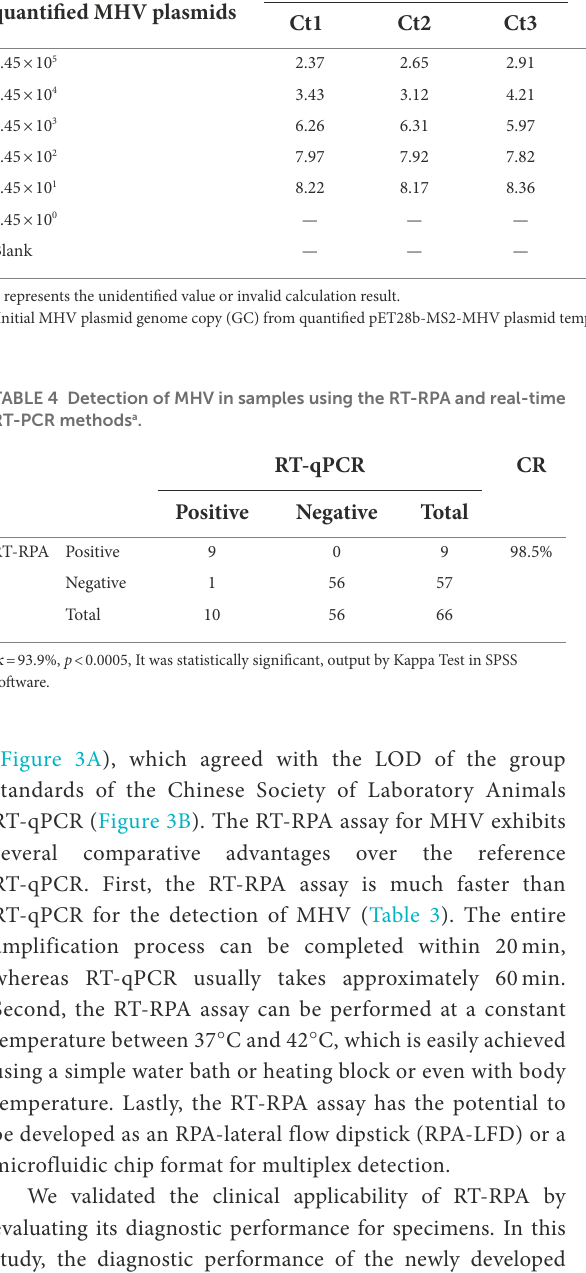
TABLE 3 Comparison of Ct values in MHV plasmids diluted for the same serial level in RT-qRPA and RT-qPCR standard curves. a Initial concentration of quantified MHV plasmids